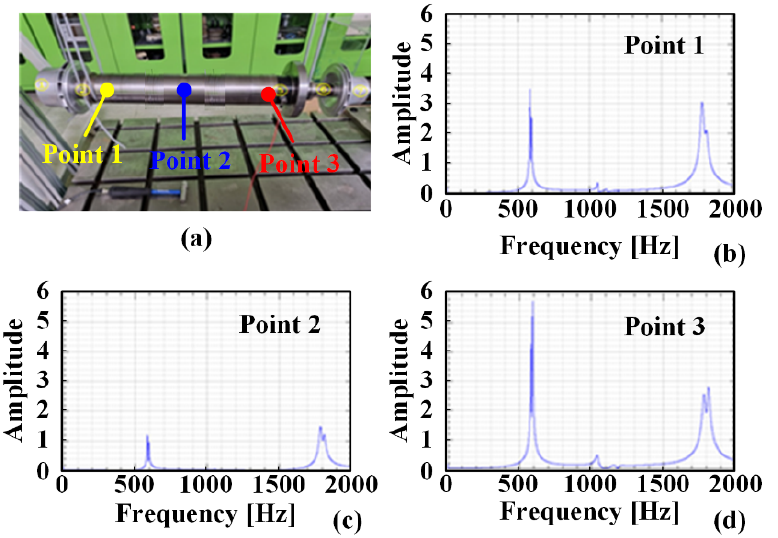
Figure 7. FRF experiment results of the rotating body: ( a ) experimental model, ( b ) point 1 test, ( c ) point 2 test, and ( d ) point 3 test.